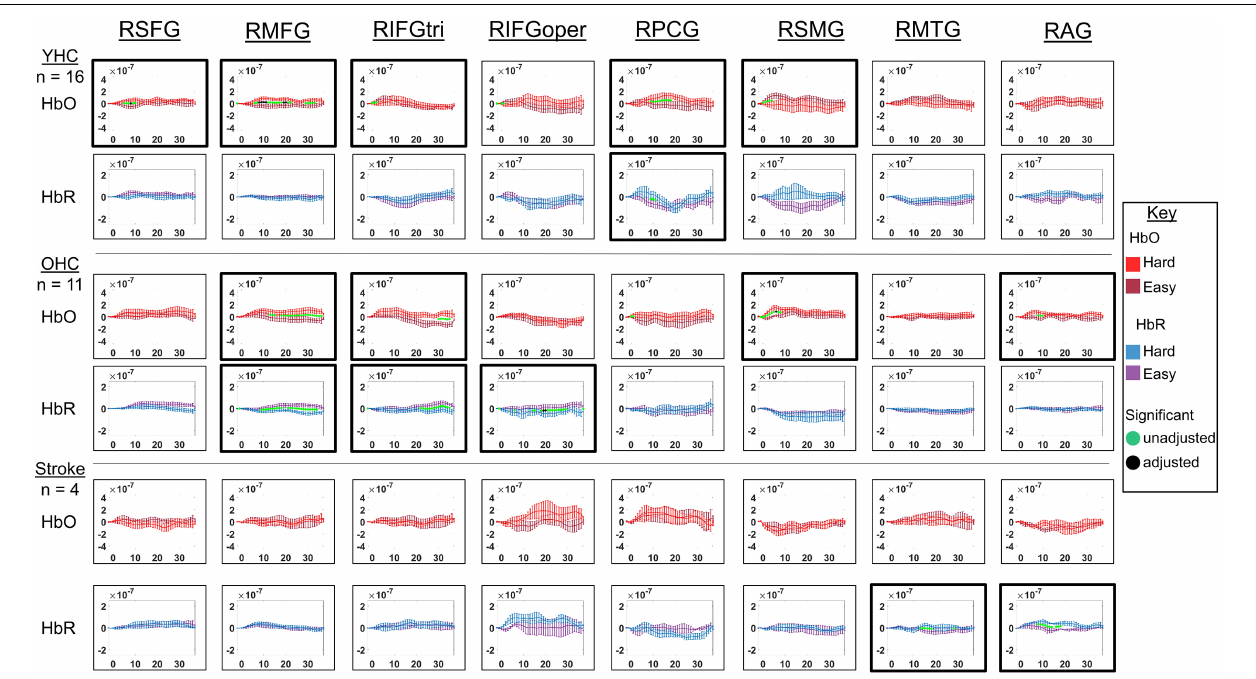
FIGURE 11 | Comparison of group average HRF between task conditions for right hemisphere ROIs during hard vs. easy addition. HbO and HbR changes in µ M units. Significant difference between task conditions at p < 0.05 level are reflected by a green dot and after FDR-adjustment with alpha of 0.05 by a black dot. Black borders denote ROIs for which there was a significant difference between the task conditions for at least three consecutive seconds. When the red line is higher than the maroon line, it suggests there was greater HbO concentration change in the hard than easy addition condition. When the blue line is lower than the purple line, it suggests there was lower HbR concentration change in the hard than easy addition condition. Both patterns are consistent with greater neural activation (i.e., increase in oxygenated blood, decrease in deoxygenated blood) in in the hard than easy addition condition and vice versa. RSFG, right superior frontal gyrus; RMFG, right middle frontal gyrus; RIFGtri, right inferior frontal gyrus pars triangularis; RIFGoper, right inferior frontal gyrus pars opercularis; RPCG, right precentral gyrus; RSMG, right supramarginal gyrus; RAG, right angular gyrus; YHC, younger healthy controls; OHC, older healthy controls; HbO, oxygenated hemoglobin concentration change; HbR, deoxygenated hemoglobin concentration